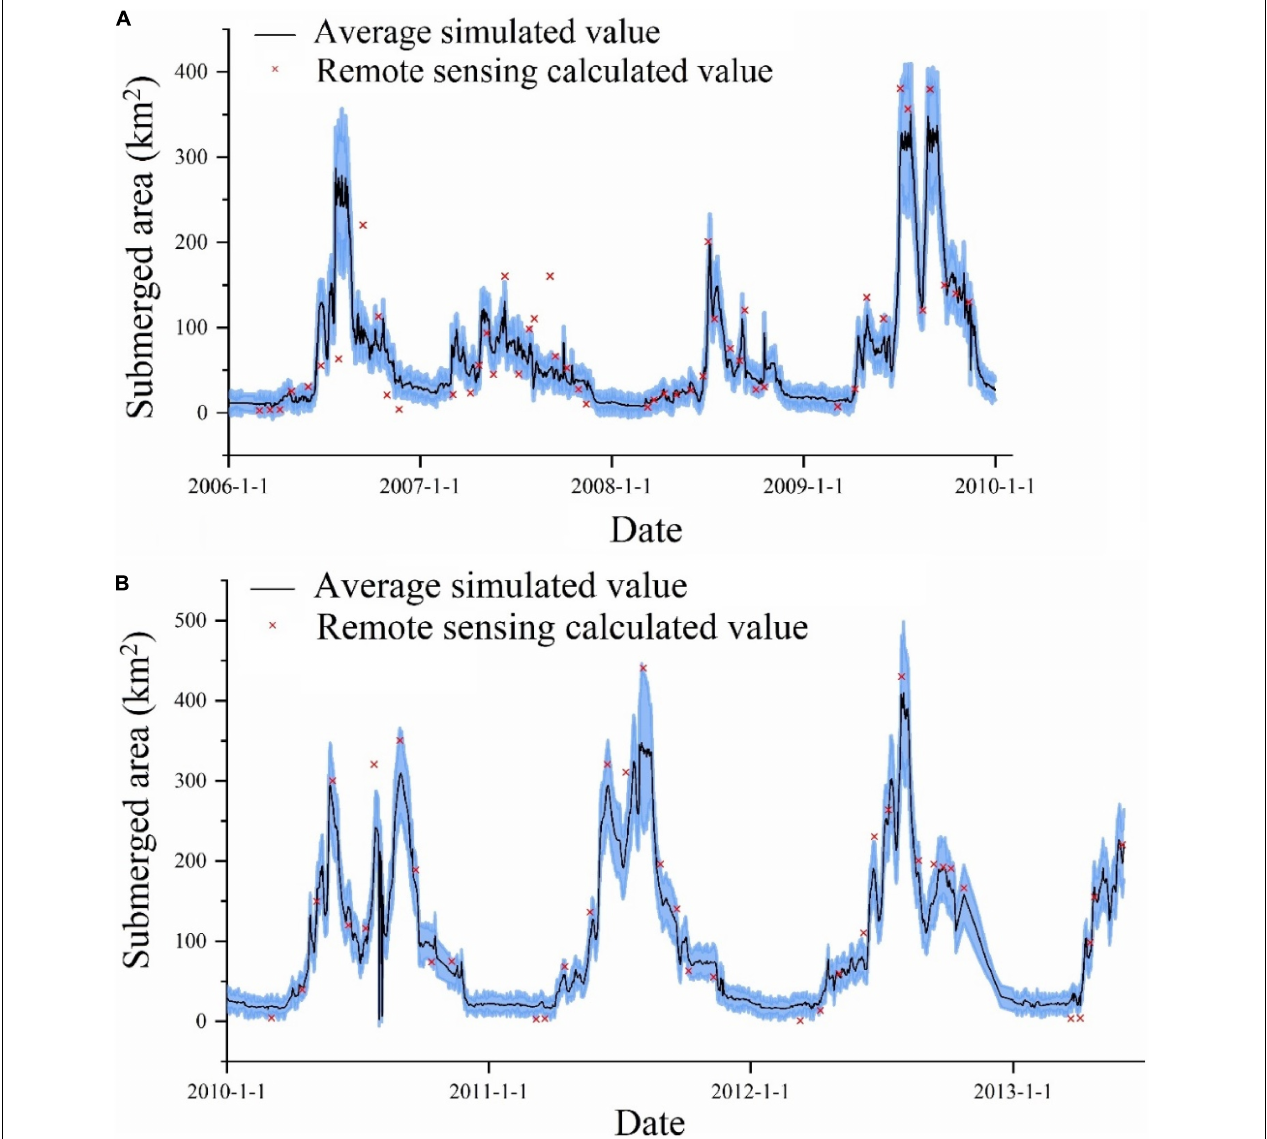
FIGURE 10 | Simulations and remote sensing observations of the total submerged area of wetland ( A: calibration period; B: validation period; blue area represents the range given across all parameter sets as evaluated for the calibration